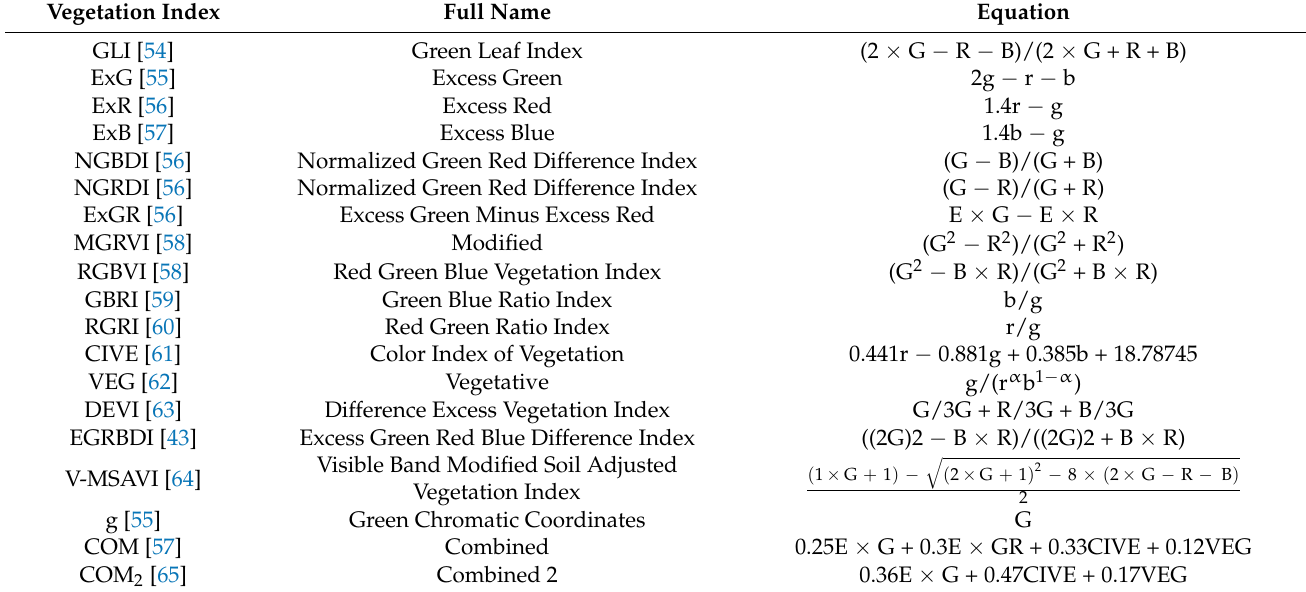
Table 2. Vegetation